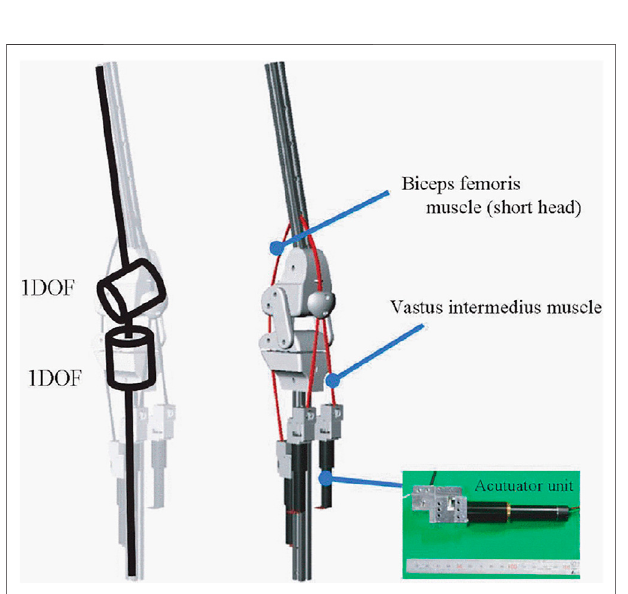
FIGURE 4| 3D model ofa bio-inspired knee joint with a patella structure (Asano et al., 2011).